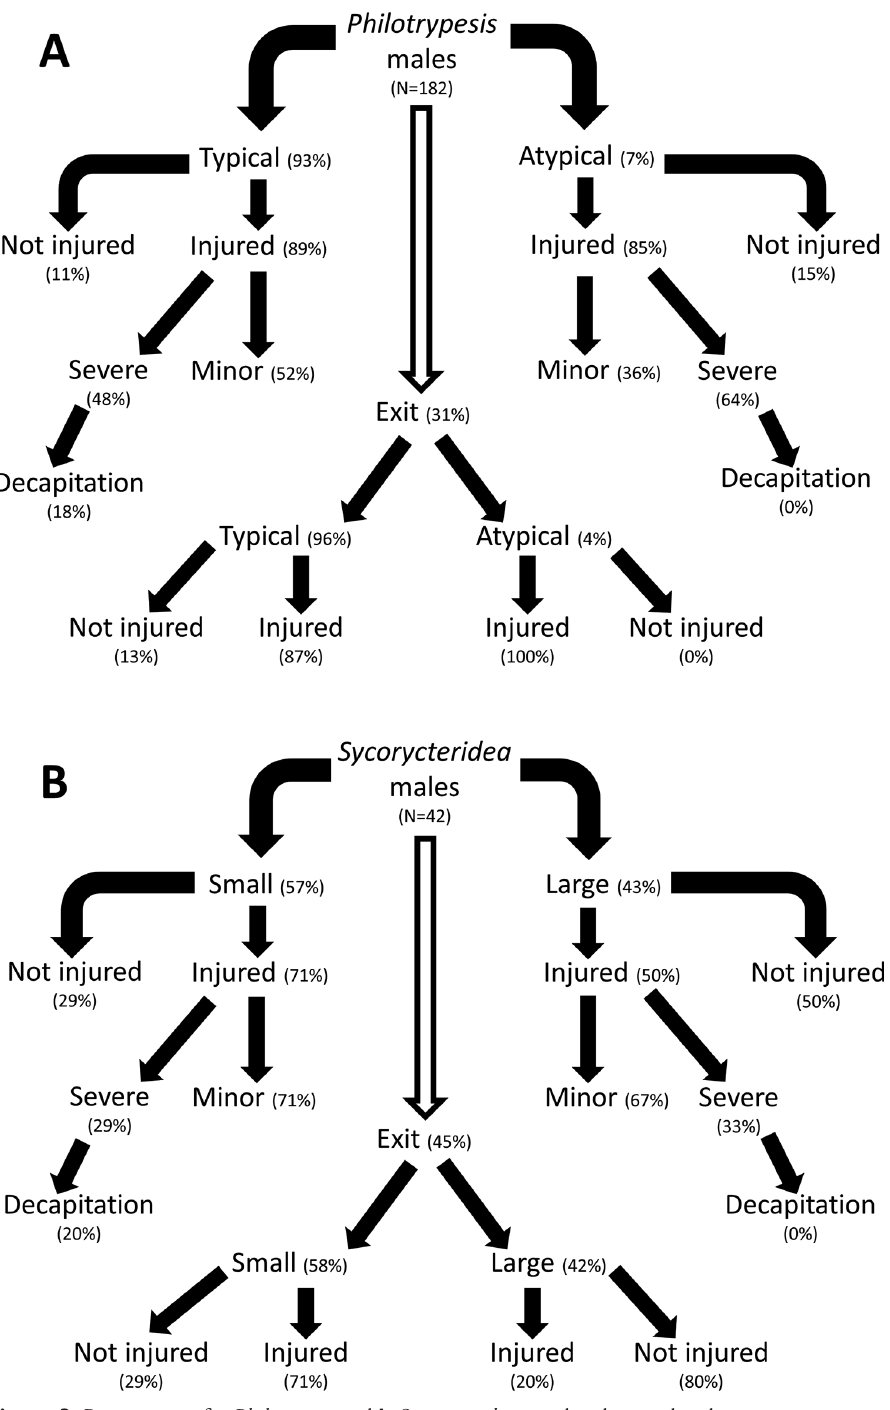
Figure 3. Proportions of a Philotrypesis and b Sycorycteridea exited and injured